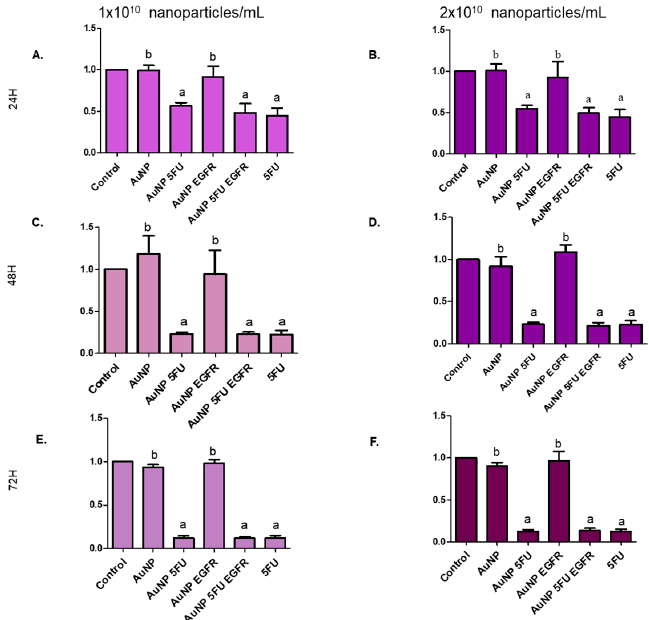
Figure 5. Representative figure of the cell proliferation assay by CellTrace ™. ( A ) Cells are pre-stained with CellTrace™, in the process of cell division, the dye is dividing between the cytoplasm of the daughter cells, decreasing the concentration at each cycle. ( B ) Histogram of CellTrace labeling in the control group. The red peak refers to 24 h of treatment; or blue 48 h; or orange 72 h. Each peak represents the cell division and consequently dilution of CellTrace into the cytoplasm. ( C ) Treatment with AuNP 5FU EGFR at the concentration of 2 × 10 10 NP/mL. Cells from this treatment did not proliferate due to cytotoxicity of the treatment, also noted the decrease in fluorescence intensity. ( D ) Treatment with free 5FU (0.38 mM), in this treatment the cells did not suffer cell division due to their cytotoxic action.